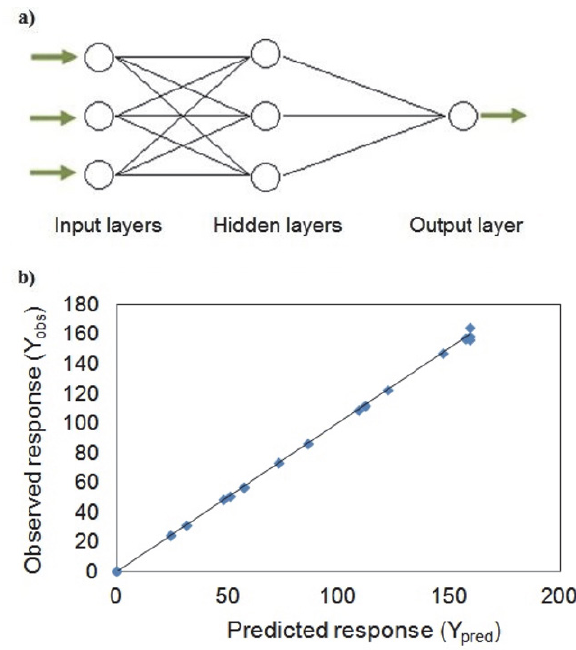
Figure 4 . Neural network architecture used for the prediction of li- pase activity (a). Parity plot showing the goodness-of-fit for RSM model (R 2 = 99.9%) (b).